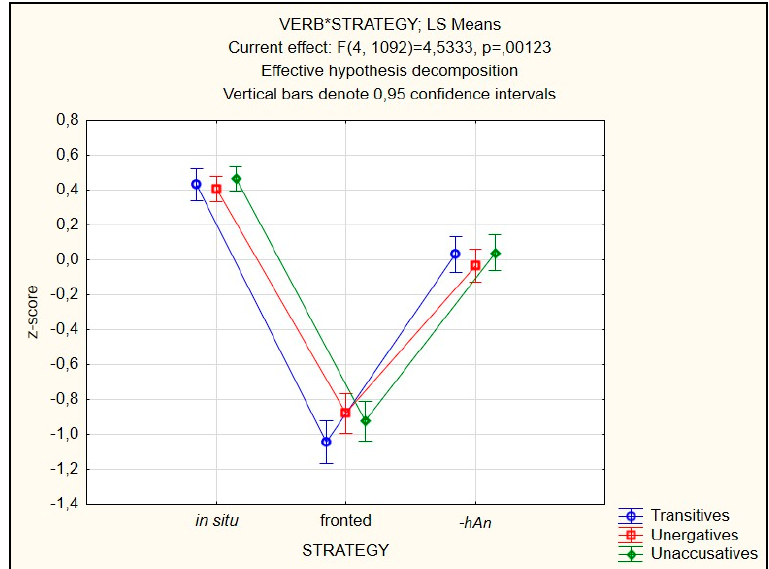
Figure 5. Verb*Strategy interaction (Finnish) .